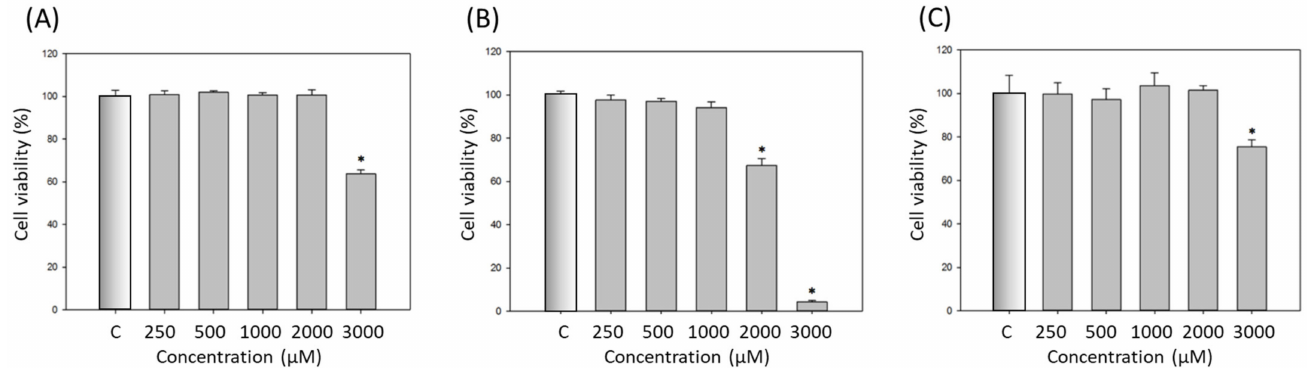
Figure 5. Cell viability of the polysorbate surfactants on B16-F10 cells: ( A ) Tween 20; ( B ) Tween 40; ( C ) Tween 80. C: control group. Data are presented as means ± SE ( n = 3); * indicates a p value of less than 0.05 when compared with the control.